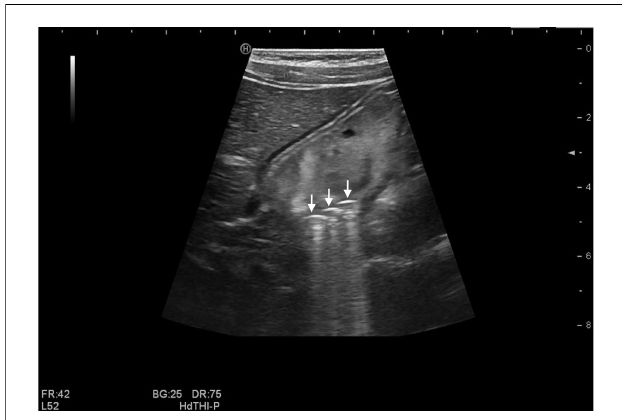
FIGURE 4 Multiple magnets in the stomach of an 11-year-old boy. Three strong, arc- shaped echoes with comet tail signs (white arrow) are seen in the stomach, with a diameter of 5 mm. No wall entrapment was